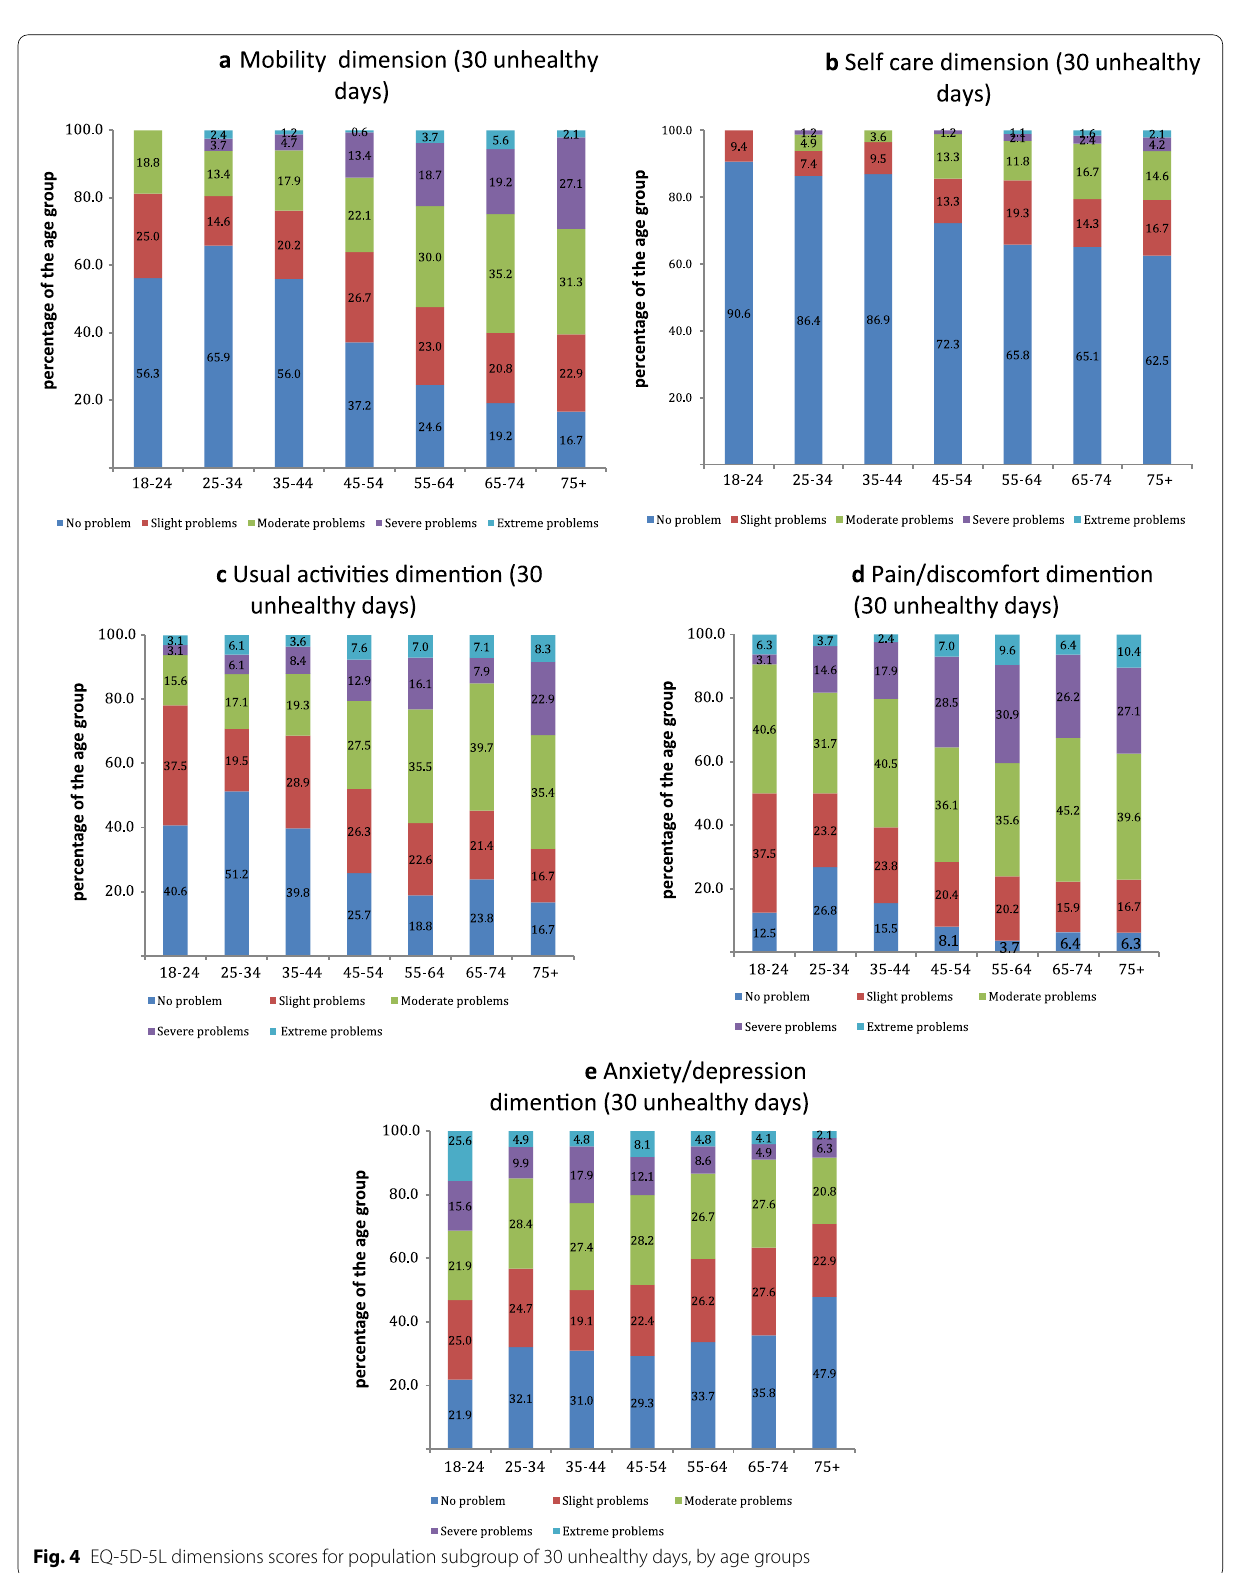
Fig. 4 EQ-5D-5L dimensions scores for population subgroup of 30 unhealthy days, by age